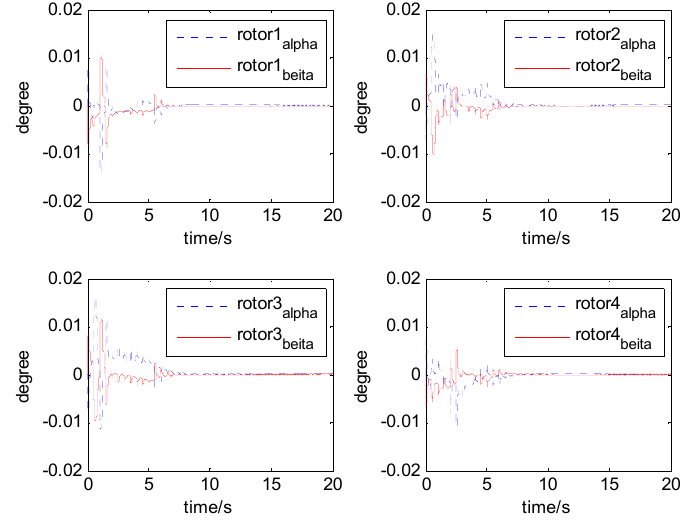
Figure 20. The magnetically suspended rotor tilt curves relative to rotor center before compensation.